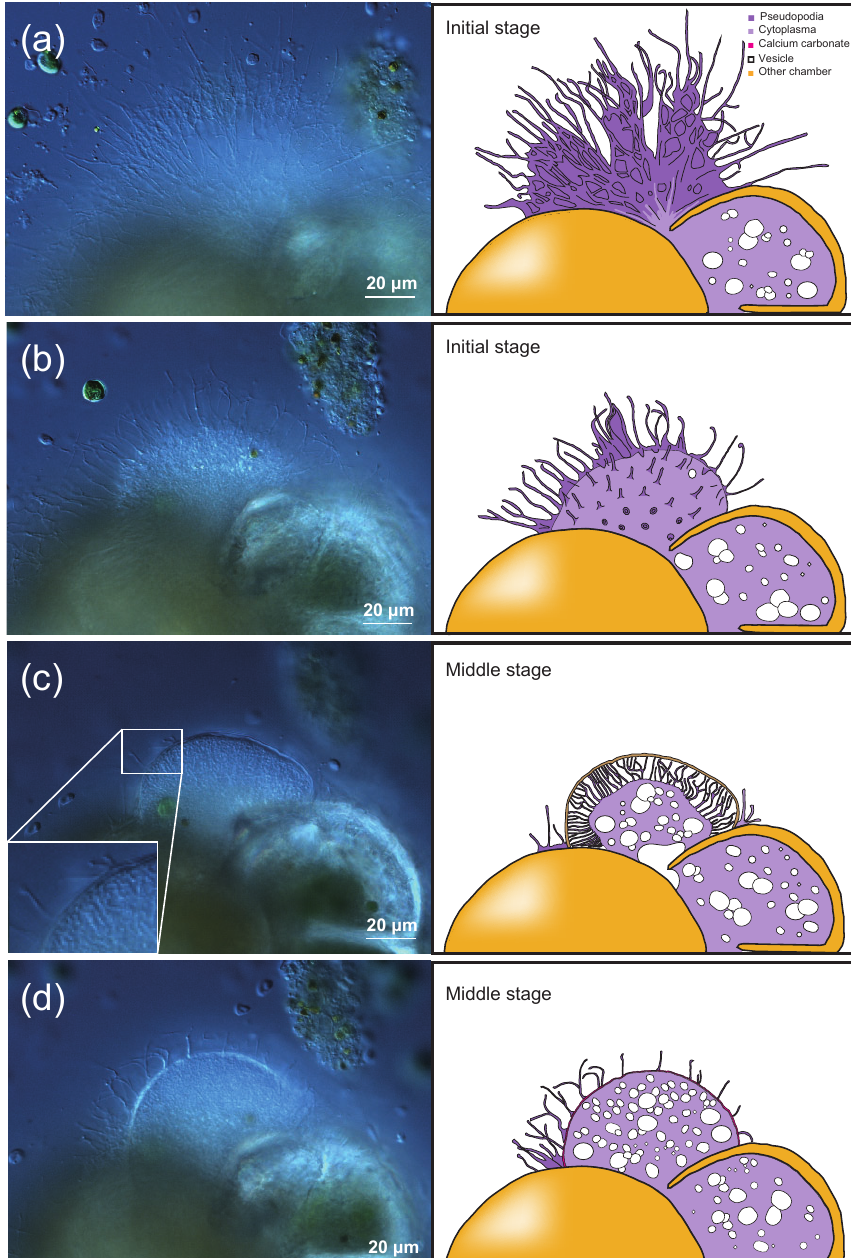
Figure 1. Time series observation of chamber formation by optical microscopy, as seen in the individual observed on 7 December 2017 (see Table 1). The initial stage of chamber formation, where the organic framework is built, is depicted by (a–b) . (a) Beginning of chamber formation, defined as 0min from the start, indicated by a dense radiating spray of the pseudopodial network. (b) 9min, when an aggregation of cytoplasm becomes visible around the aperture of the last existing chamber. As this cytoplasm expands, the pseudopodial network starts to retract to the surface of the new chamber to complete the framework. The middle stage, where the organic framework is being prepared for calcium carbonate precipitation, which begins at near the end of this stage, takes place between 15 to 60min, as depicted by (c–d) . (c) 27min, cytoplasm concentrates and outline of newly forming chamber wall is now clearly visible, pseudopodia still just visible on the surface. (d) 41min, pseudopodial retracts inside the forming chamber wall. Left: optical microscopy image. Right: the same image with schematic overlay. Colour legend: deep purple = pseudopodia; light purple = cytoplasm; magenta = calcium carbonate in the newly forming chamber; yellow = previously formed